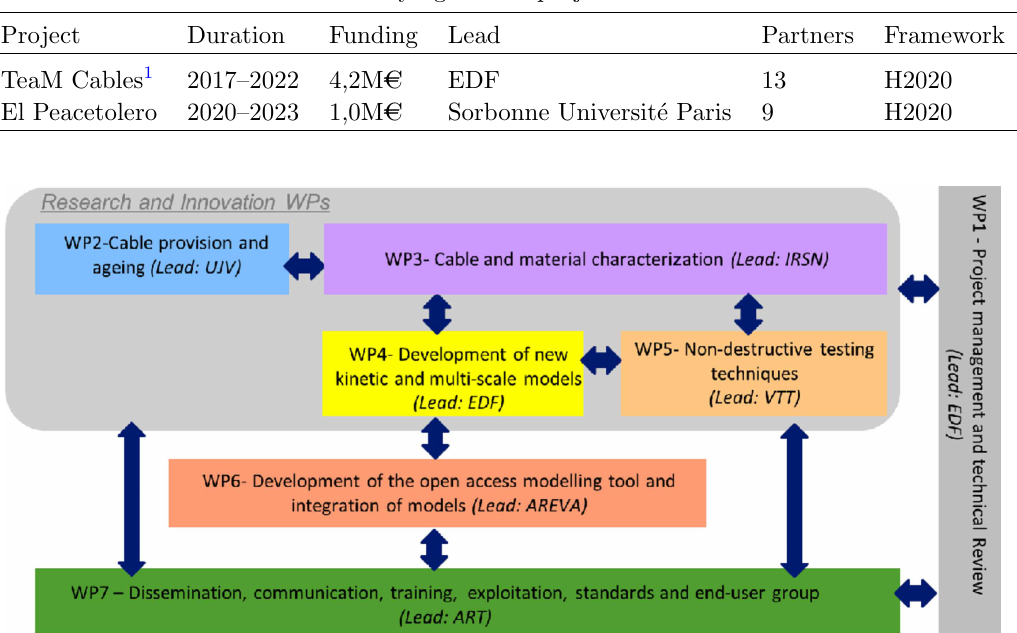
Fig. 1. TeaM Cables work